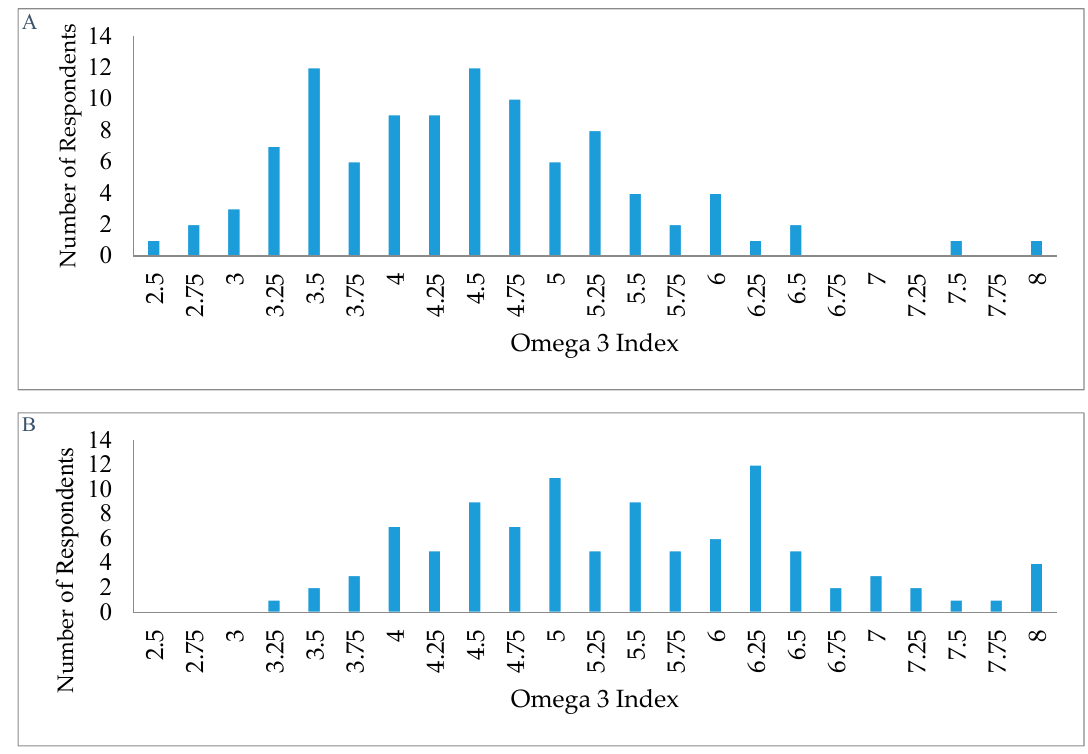
Figure 2. Individual Omega-3 fatty acid values in the United States (Panel A ) and Germany (Panel B ).